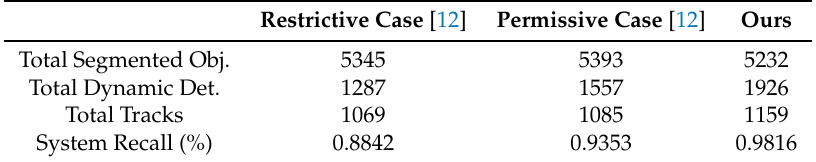
Table 1. Results over the real captured sequence of the presented extended DATMO